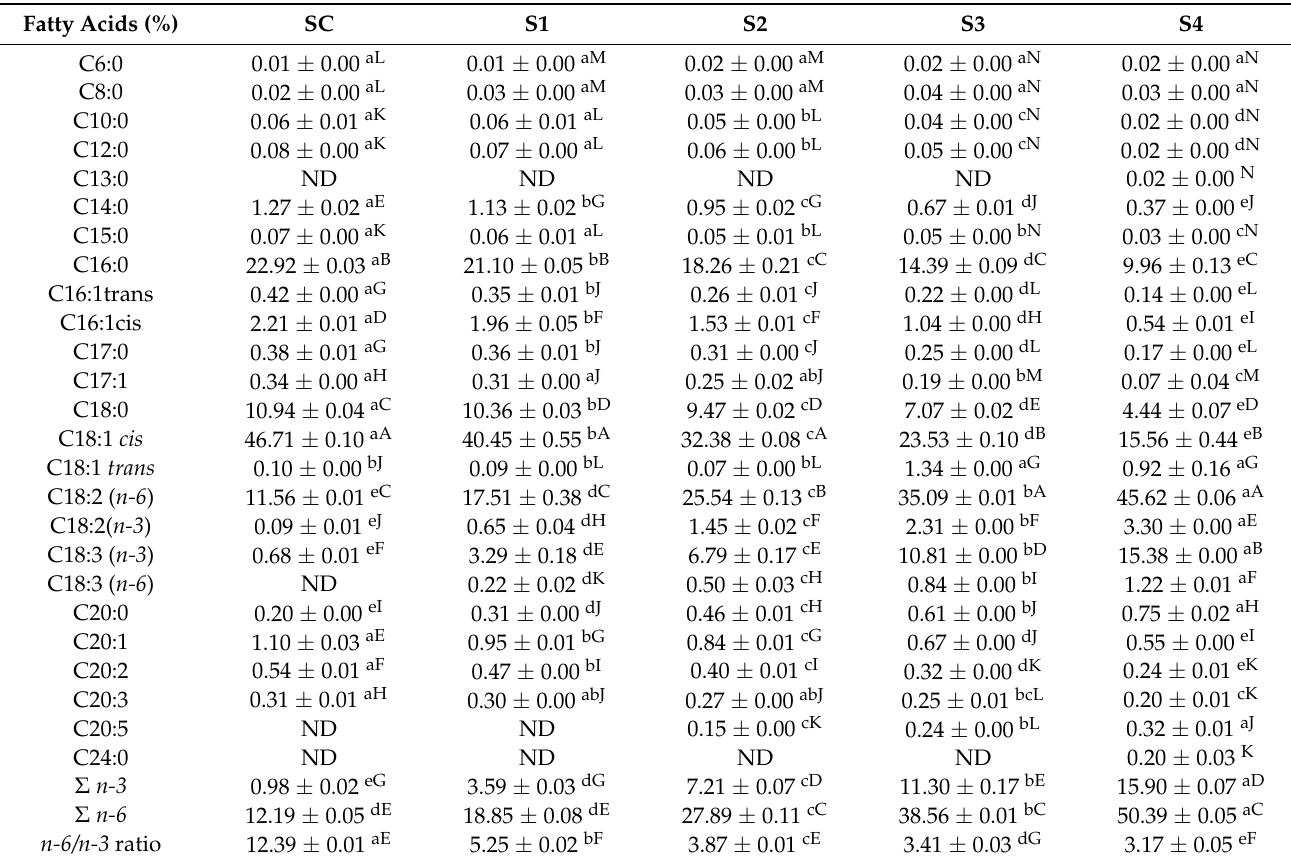
Table 2. Effect of partial and total replacement of pork back fat by the gelled emulsion from hemp oil and buckwheat flour, on lipid profile and nutritional parameters of